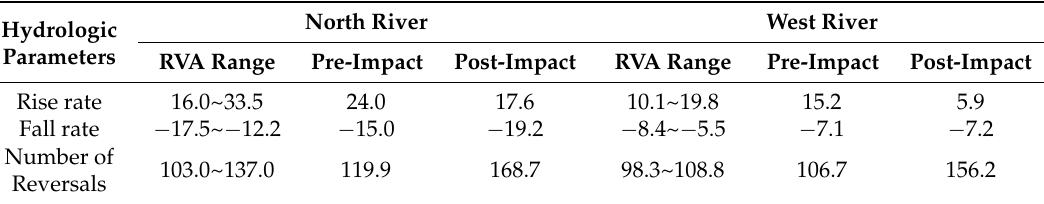
Table 7. The suitable ranges of the rate and frequency in the